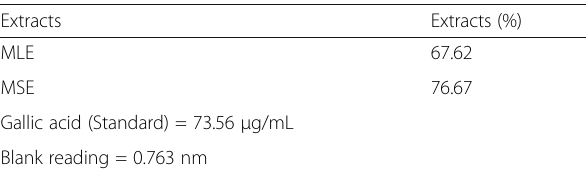
Table 3 Total phenolic contents (%) in different extracts of B. lupulina